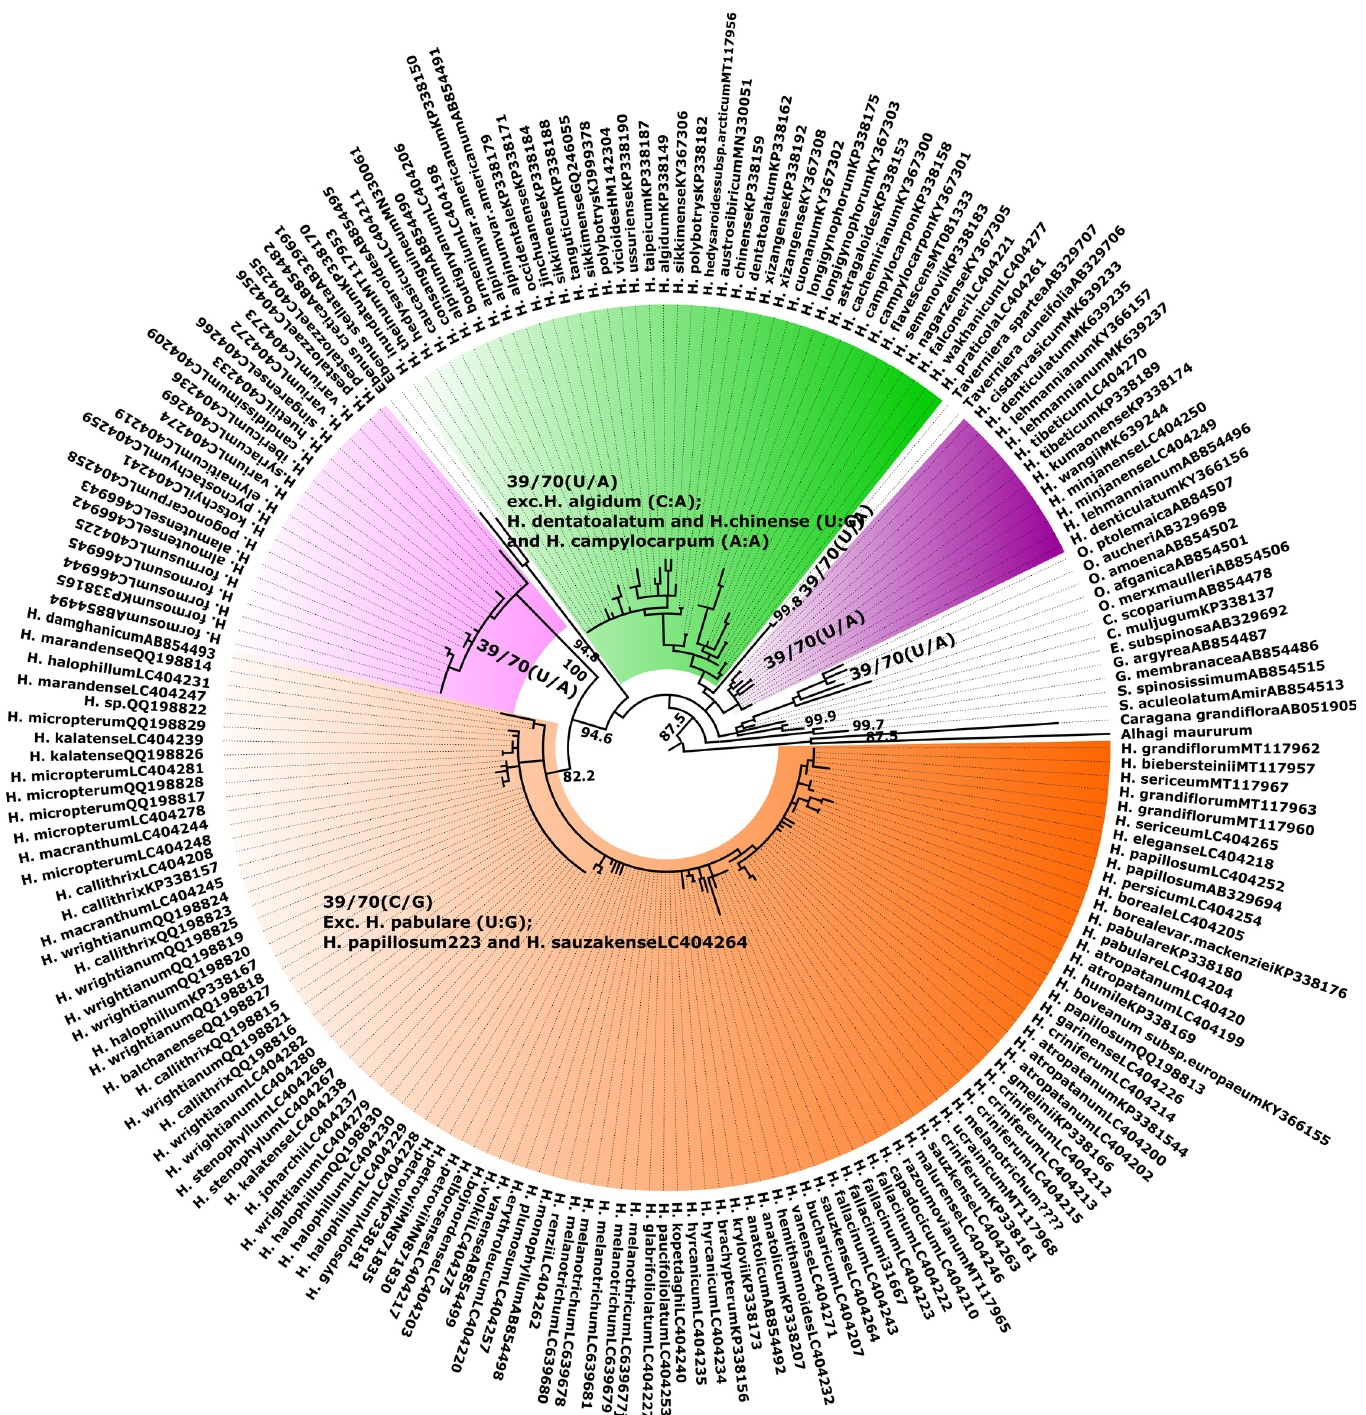
Fig 2. ITS2 sequence-structure Maximum-Likelihood tree calculated with R including a representative subset of 204 sequence-structure pairs from Hedysarum and its affiliated genera. Bootstrap support values from 1000 pseudo-replicates greater than 50% mapped at the internodes. The blue blocks represent conserved motifs.